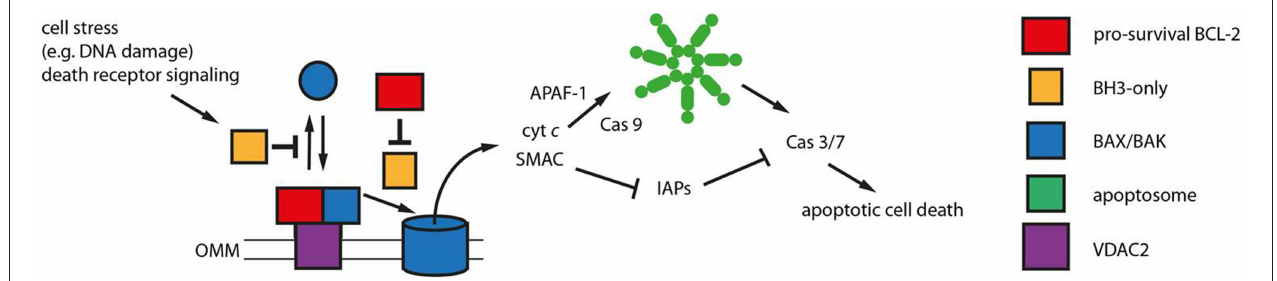
FIGURE 2 | Mitochondrial apoptosis signaling. Mitochondrial apoptosis is regulated by members of the BCL-2 protein family on the outer mitochondrial membrane (OMM). The pro-apoptotic BCL-2 proteins BAX and BAK (blue) constantly translocate to the OMM undergoing a conformational change. The porin voltage-dependent anion channel 2 (VDAC 2, purple) acts as mitochondrial BAX/BAK receptor and as platform for the retrotranslocation of BAX and BAK back into the cytosol dependent on the activities of pro-survival BCL-2 proteins (red). The equilibrium between BAX/BAK translocation and retrotranslocation determines the cellular predisposition to apoptosis. Intrinsic stress as well as death receptor signaling is mediated by BH3-only proteins (yellow) that inhibit BAX/BAK retrotranslocation shifting BAX and BAK toward the mitochondria. The BH3-only proteins tBID, BIM and PUMA are also thought to directly activate BAX and BAK initiating OMM permeabilization and the release of cytochrome c (cyt c ) and SMAC into the cytosol. This function can be inhibited by pro-survival BCL-2 proteins. Cytosolic cyt c initiates in turn the formation of the apoptosome (green), an APAF-1 complex activating Caspase 9 (Cas 9). Subsequently, Caspases 3 and 7 are activated that can be inhibited by IAPs in